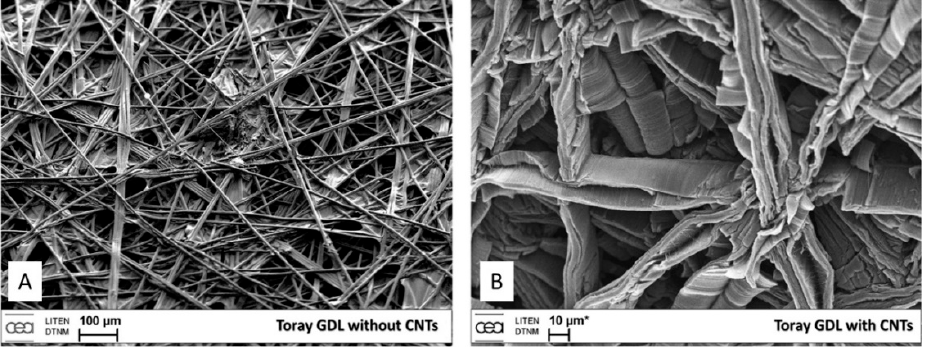
Figure 32. Top–view SEM micrographs of ( A ) As-received Toray GDL and ( B ) VACNT/ Toray GDL. Reprinted with permission from Fontana, Carbon; Ref. [47] copyright 2020, Elsevier.